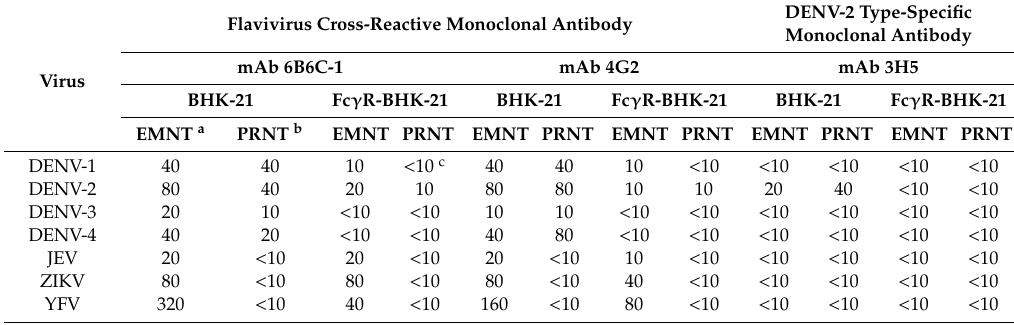
Table 3. Neutralizing Titers of 13 ZIKV IgG Positive Clinical Samples to ZIKV by Using BHK-21 Cells.